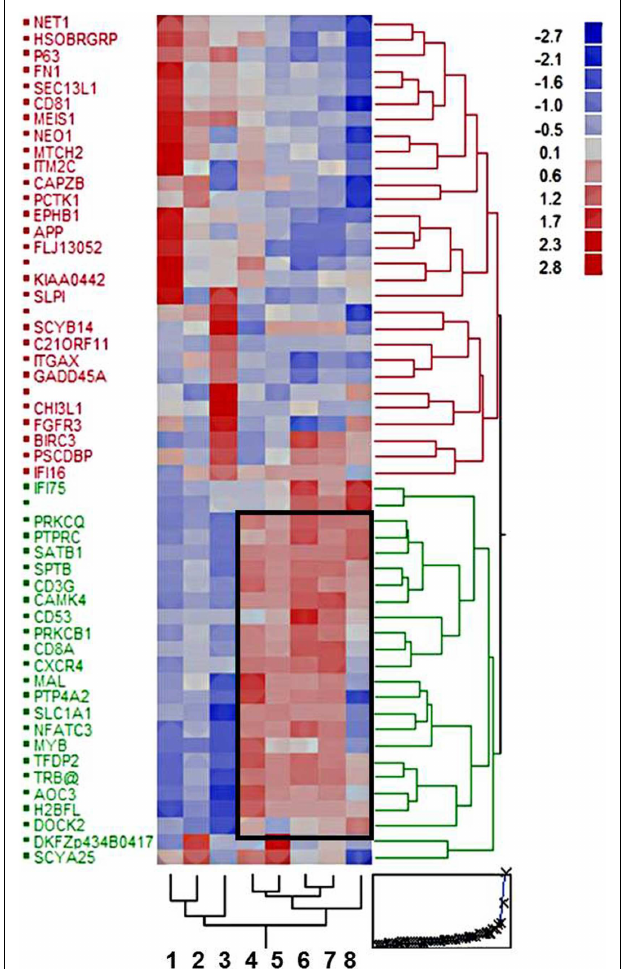
FIGURE 1 | Hierarchical clustering of eight tissue cohorts: typeA,AB, B2, and B3 thymomas; thymic squamous cell carcinomas (TSCCs); non-neoplastic thymuses (normal and MG-associated thymitis); and Ficoll gradient-purified thymocytes based on 53 differentially expressed genes ( p < 10 − 10 ) .The frame delineates 19 genes with coordinate up-regulation in the lymphocyte-rich cohorts, most of which ( n = 13) play a role in lymphocyte biology (for details see